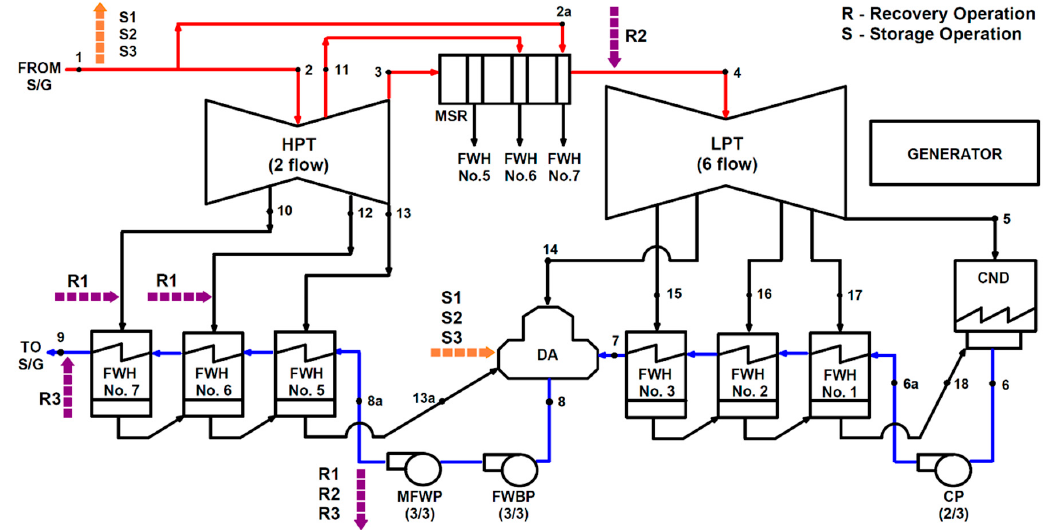
Figure 1. Simplified diagram of APR1400 Turbine Cycle with the Nuclear Heat Storage and Recovery (NHS&R) System energy flows. (The detailed explanation of energy flow configuration is provided in Section 2.4. The abbreviations are explained in the Abbreviations List).